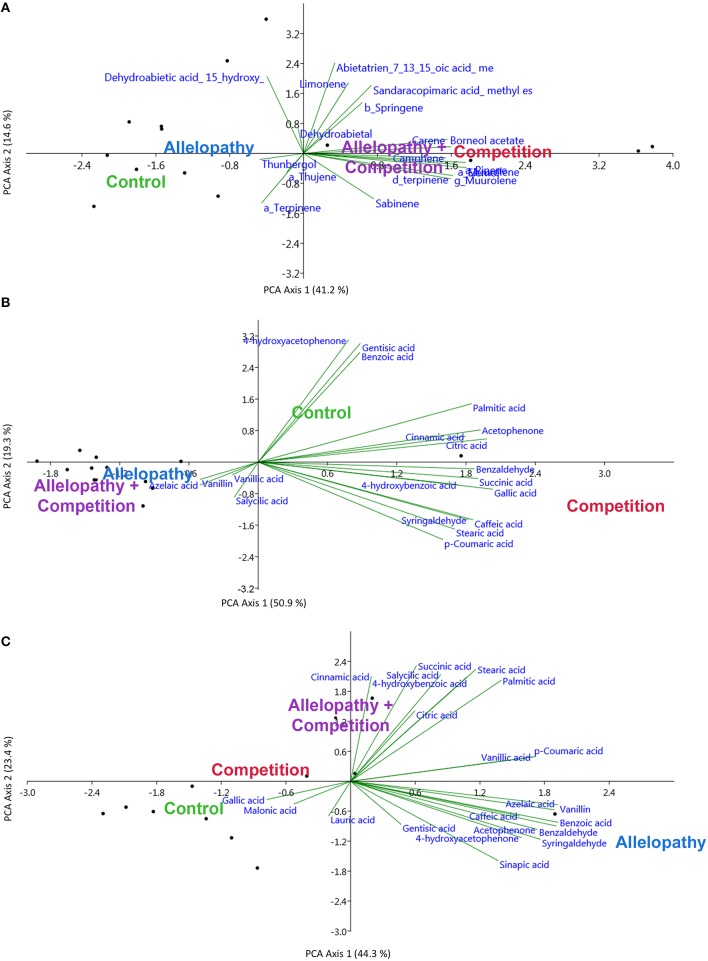
Principal component analyses performed for metabolites most closely associated with responses to A, C, and AC (SIMPER analysis), for terpenoids for Pinus (A) and for polar metabolites in Pinus (B) and Quercus (C).